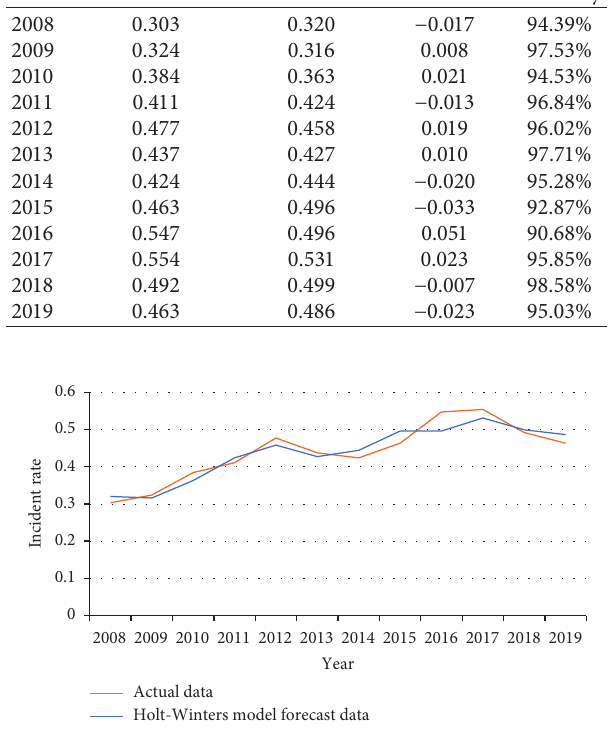
Figure 3: Comparison of Holt-Winters model forecast data and actual data. Table 6: The prediction and fitting data of the combined prediction model.